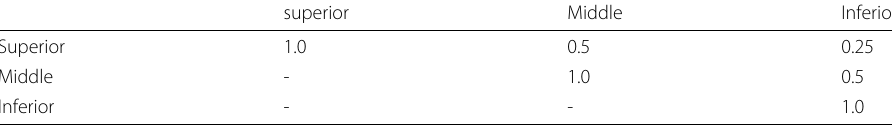
Table 7 WEIGHT values for edges between patches in different lobes superior Middle Inferior Superior 1.0 0.5 0.25 Middle - 1.0 0.5 Inferior - - 1.0